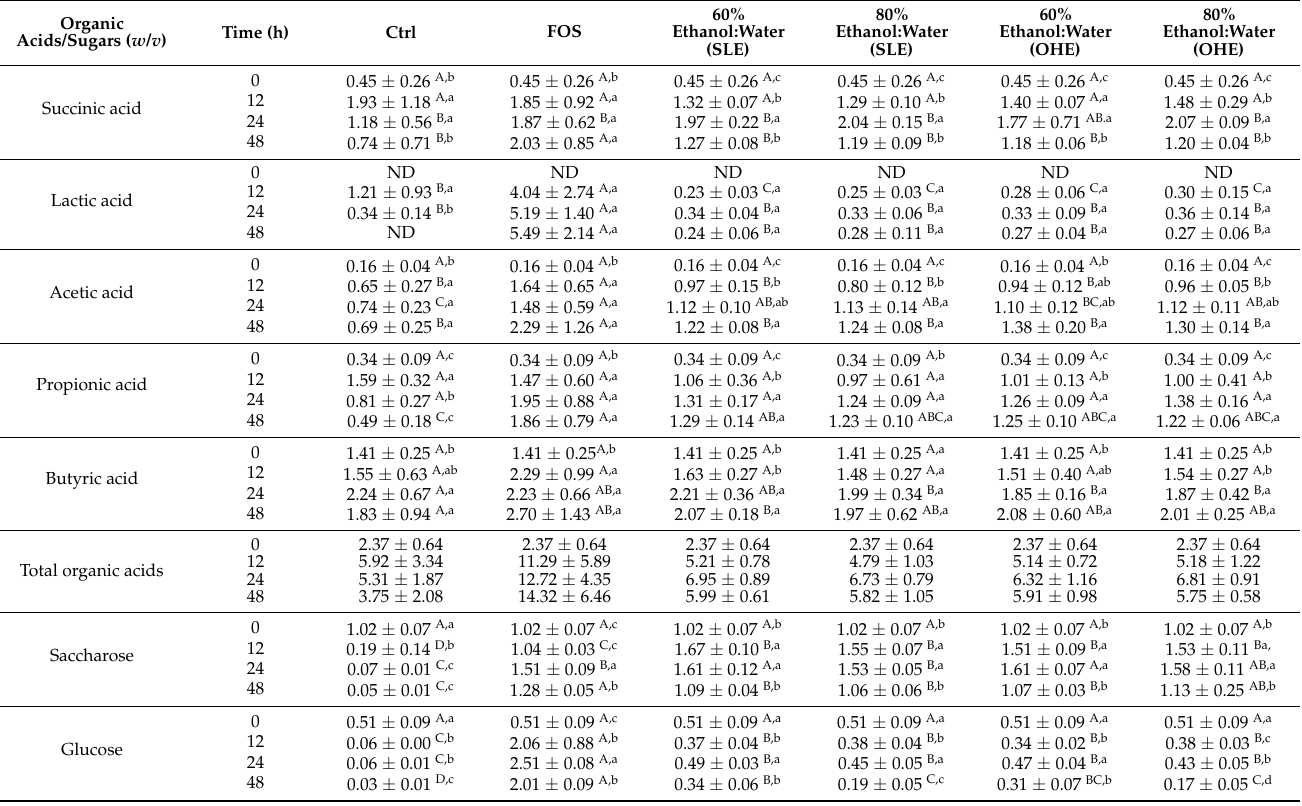
Different letters indicate significant differences ( p < 0.05). The capital letters indicate the differences among the Ctrl, FOS, 60% ethanol:water and 80% ethanol:water ( v/v ) (SLE and OHE) for organic acids and sugars concentration at the same time (same row), and the lowercase letters indicate the differences for the same sample over time for each organic acid and sugars concentration (same column within an organic acid). Data represent the mean ± SD of five independent